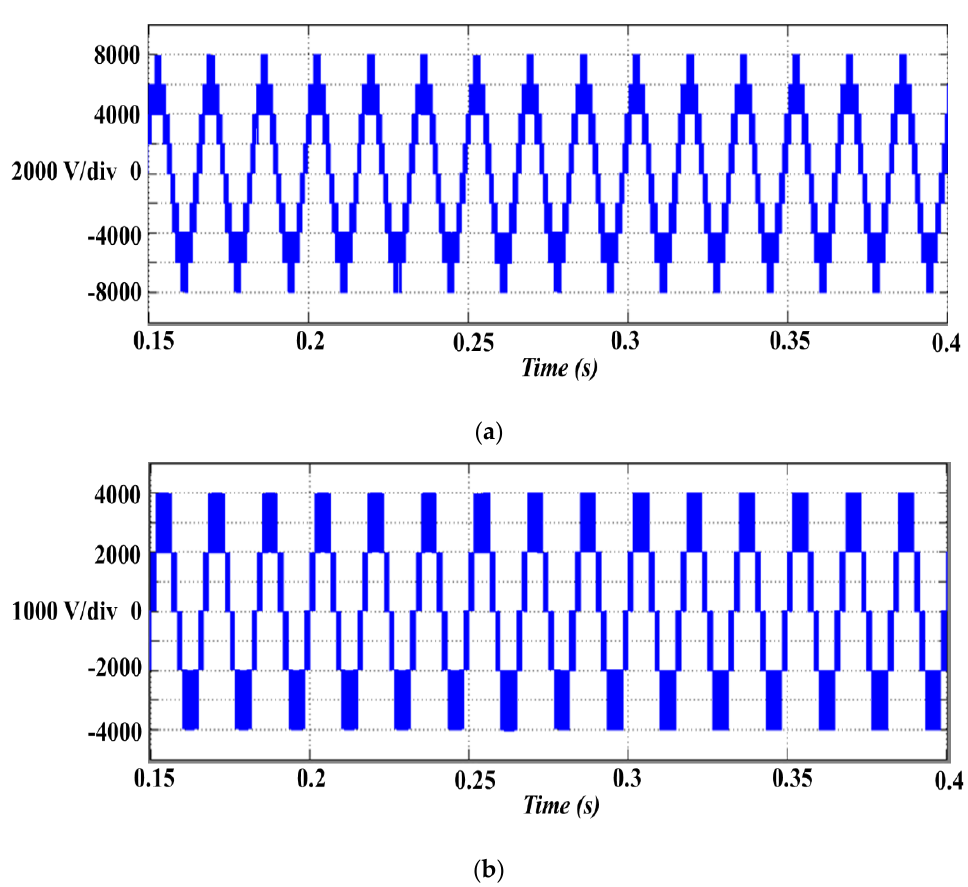
Figure 7. Simulation waveforms of the proposed five-level STATCOM. ( a ) Line-to-line output voltage ( V AB ); ( b ) Phase output voltage ( V AN ).